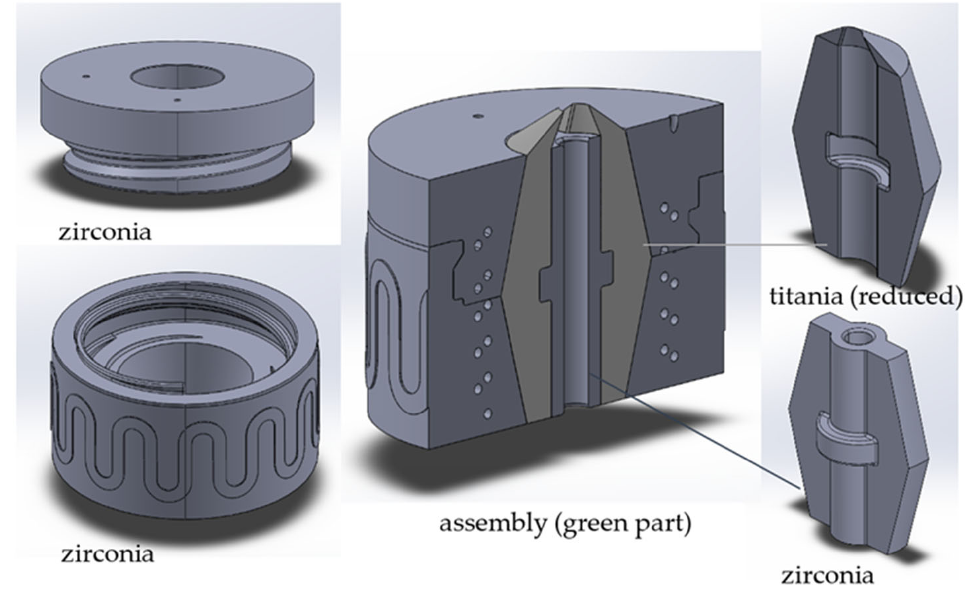
Figure 1. Custom ‐ fit core–shell assembly consisting of four single material components printed by Figure 1. Custom-fit core–shell assembly consisting of four single material components printed VPP. by